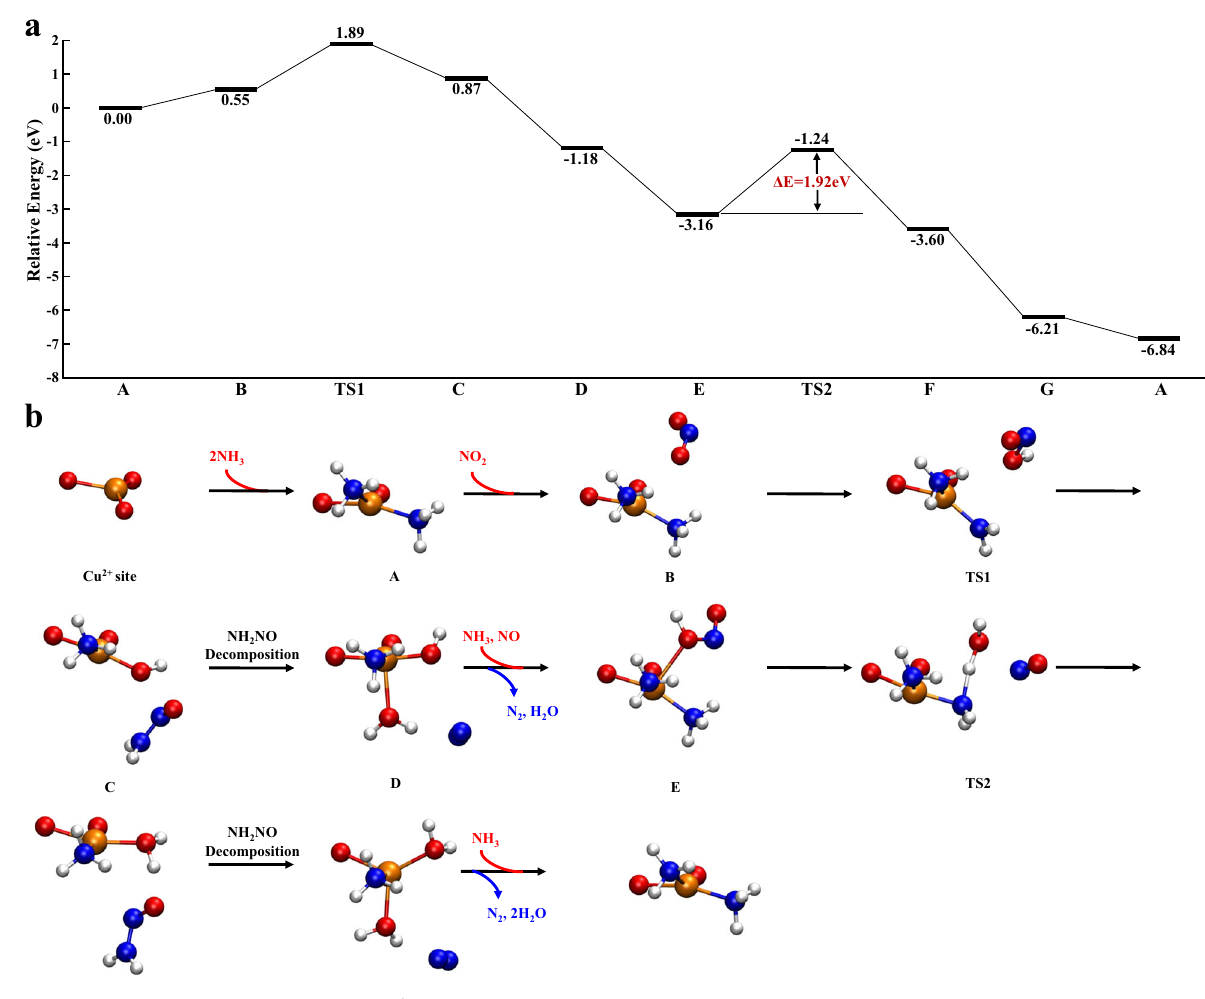
Fig. 4 | Reactionpathway of thefastSCRcycleatZ 2 Cu II site.a Gibbs free energy pro fi le. b Optimized geometries of the reactants, transition states (TSs) and pro- ducts for all elementary steps are presented in the lower panel. Except for the O